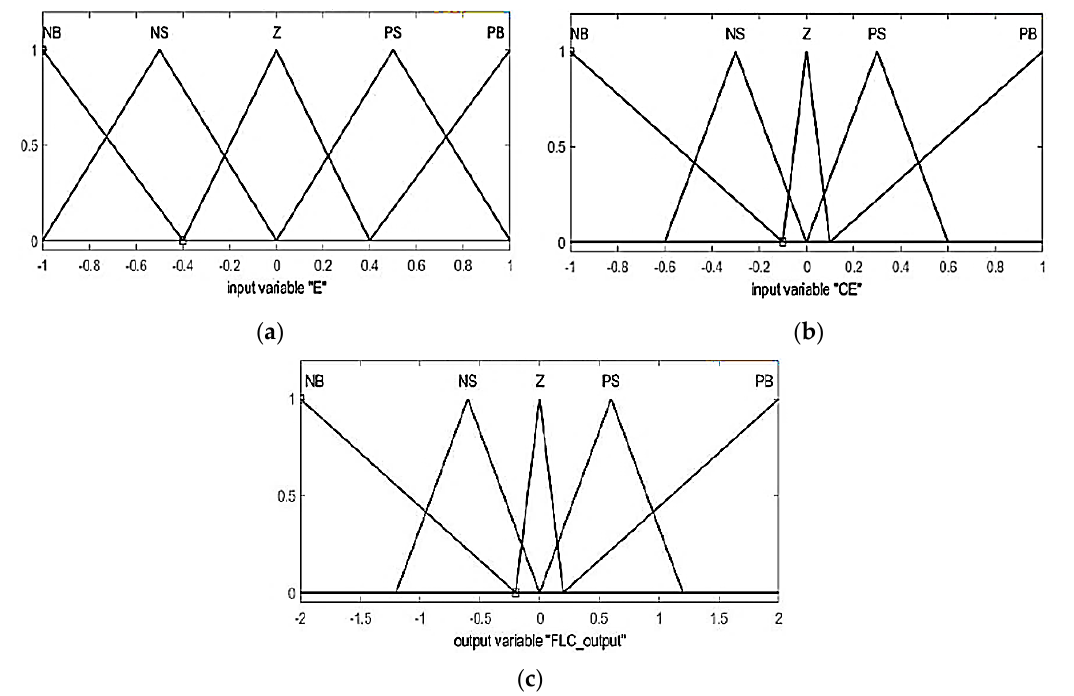
Figure 6. Membership functions for: ( a ) Input E; ( b ) Input CE; ( c ) Output . Table 3. Fuzzy Logic Control Rule Table.